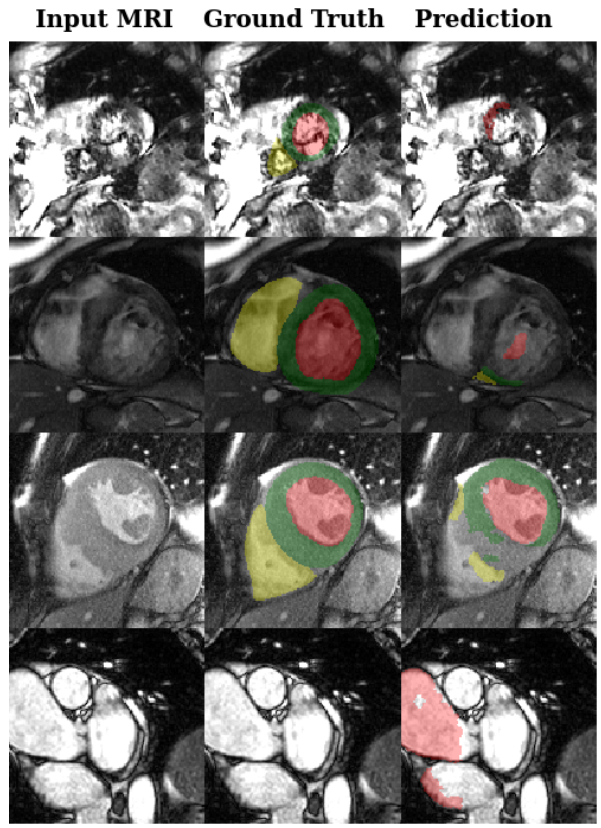
Figure 2. Examples of bad output segmentation on the M&Ms data set for the left ventricle, right ven- tricle and myocardium.